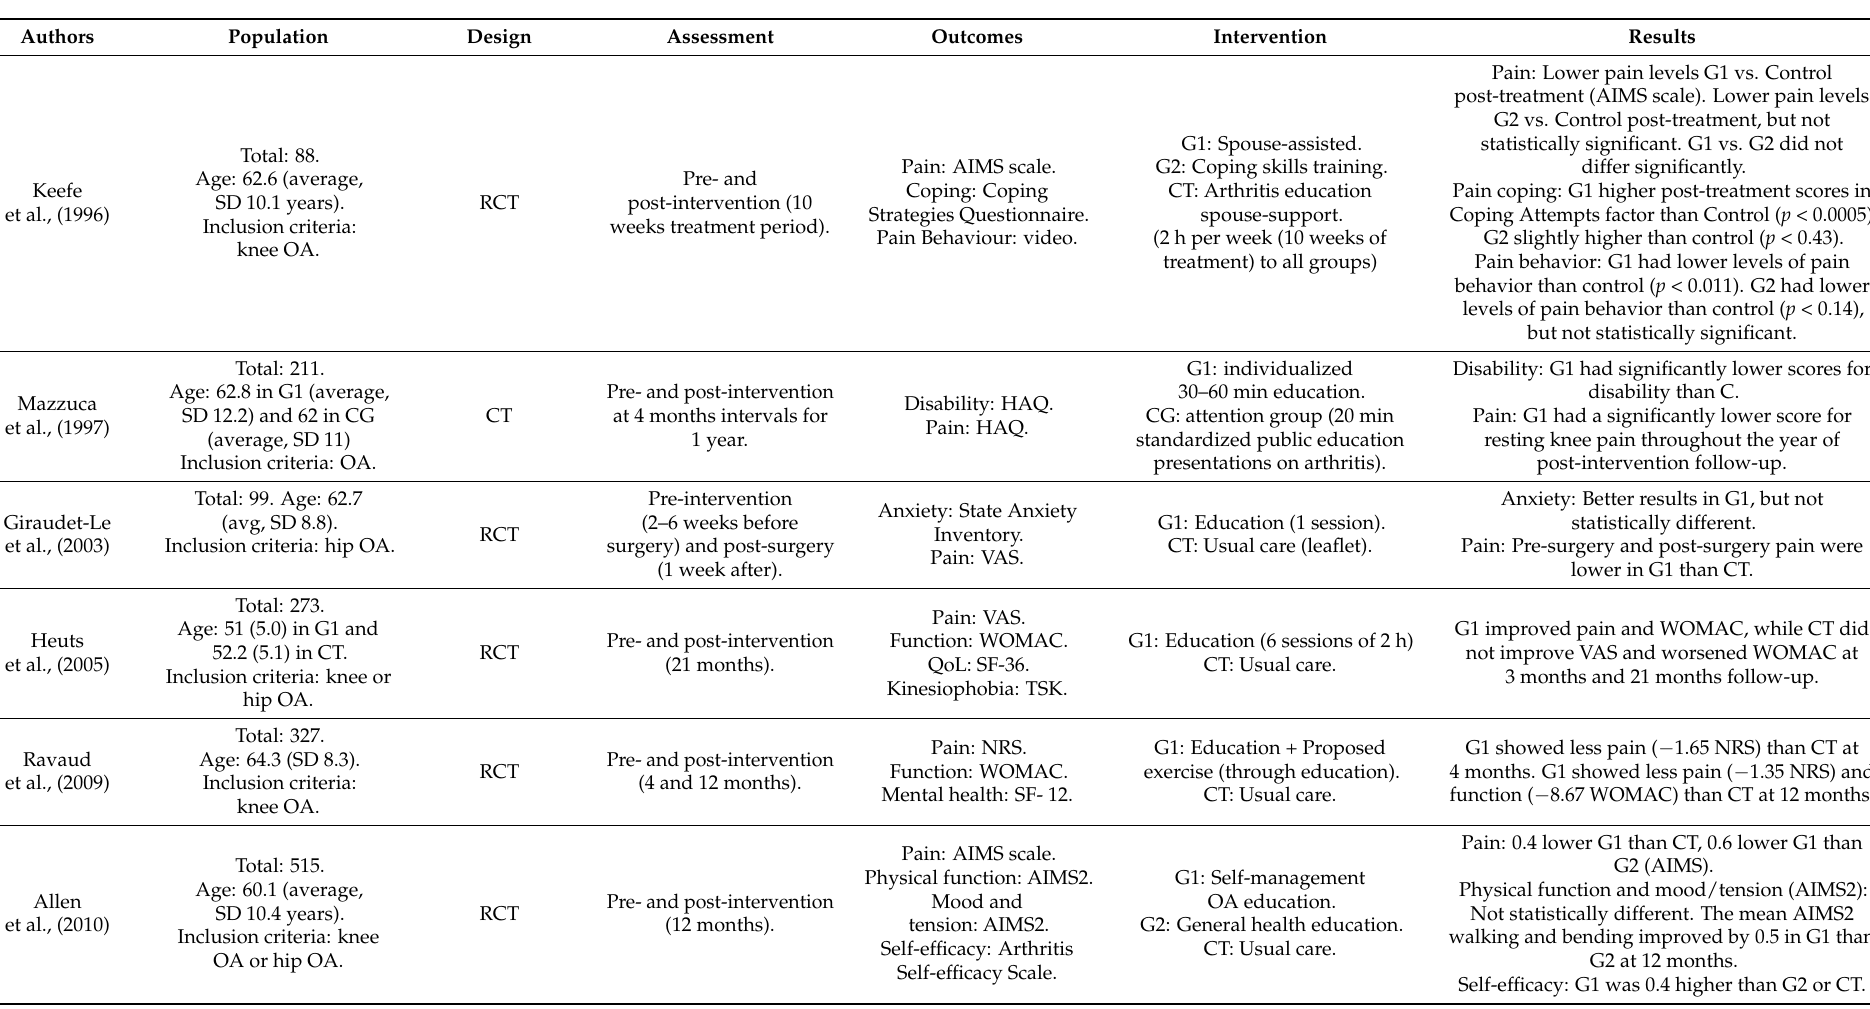
Table 3. Characteristics of included